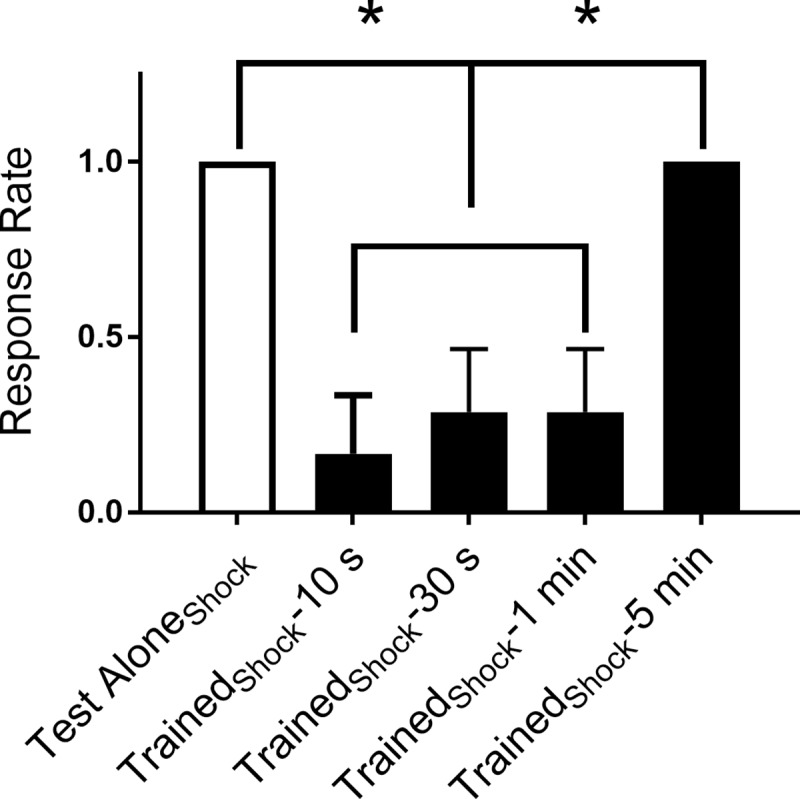
Rapid habituation of touch-induced C-start.Effect of electric shocks delivered at 1 Hz on the touch-induced C-start reflex. All groups, except one (Test AloneShock, n = 7), were given posttests at various times after habituation training to determine the duration of the habituation with electric shocks. The Test AloneShock group received the test stimuli without habituation training. A between-groups ANOVA yielded a significant group effect (F[4,
29] = 9.22; p < 0.05). Tukey HSD post-hoc tests revealed that the TrainedShock-10 s group (n = 6), TrainedShock-30 s group (n = 7), and the TrainedShock-1 min (n = 7), were significantly less responsive than the Test AloneShock group (n = 7), and the TrainedShock-5 min (n = 7) group.